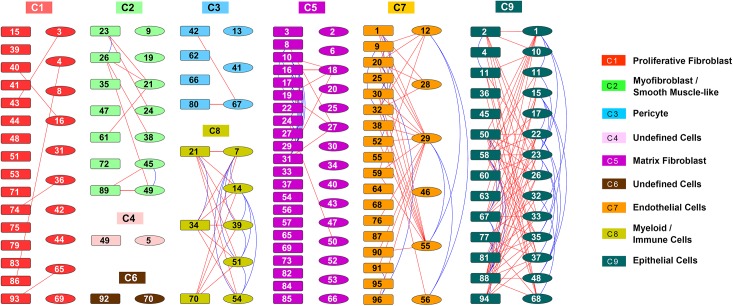
Identification of Major Lung Cell Types.Cells (n = 148) from two sample preparations from fetal mouse lung at E16.5 were assigned into 9 clusters via hierarchical clustering using average linkage and centered Pearson’s correlation. Each color represents a distinct cell cluster, labeled as C1-C9. The rectangles represent single lung cells from the first preparation and the ellipses consist of single cells from a second independent preparation. Connection lines indicate the z-score correlation between the two cells > = 0.05. The blue lines connect cells within the same preparation, while the red lines connect cells across preparations.